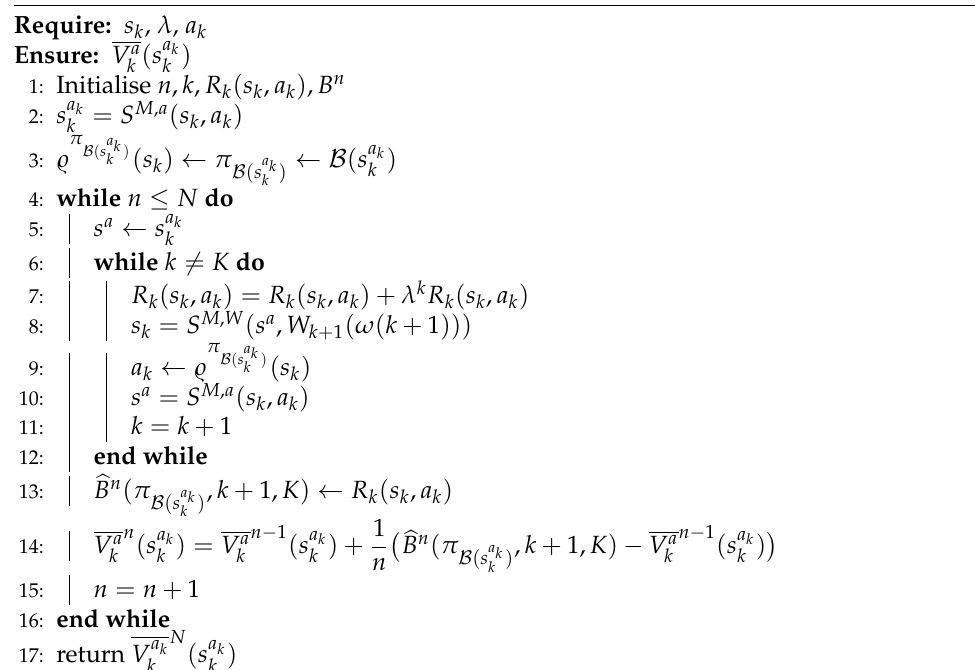
Algorithm 1 Compute V a highlighted in